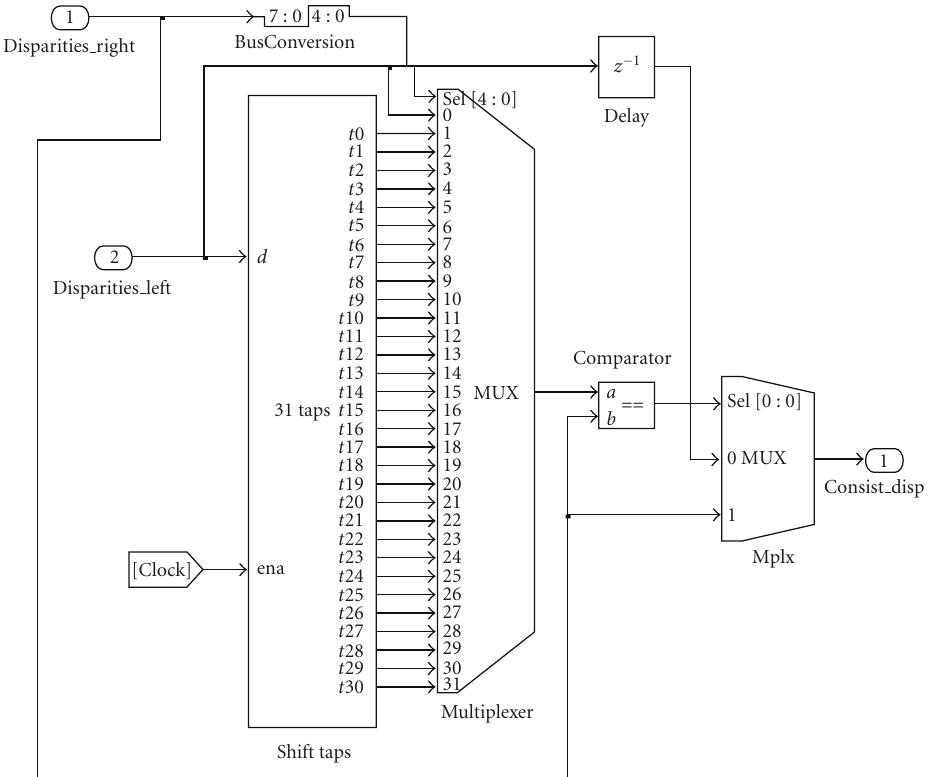
Figure 6: Implementation of the left-right consistency